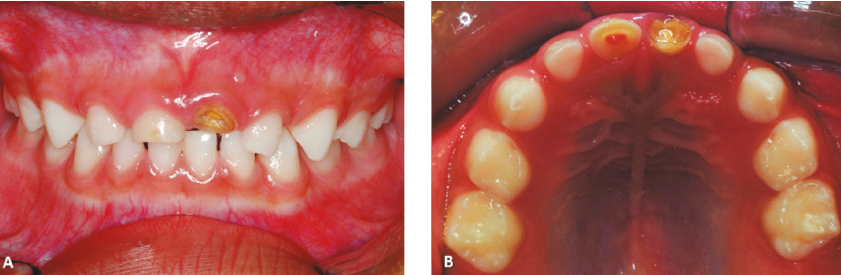
Figure 1: (A) Facial view of traumatized teeth, enamel-dentin-pulp fracture of (51), and crown-root fracture with pulp involvement (fistula) of (61) . (B) Occlusal view of (51) and (61) note the presence of pulp polyp (61)